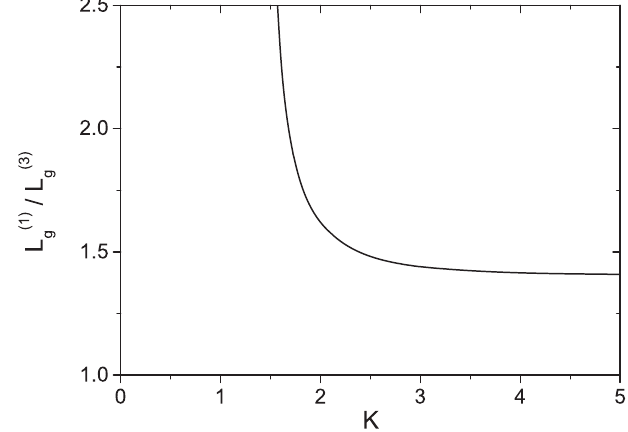
FIG. 2. Ratio of the gain length of the retuned fundamental to the gain length of the third harmonic (3) for lasing at the same wavelength versus rms undulator parameter K . The ratio is derived in the frame of the three-dimensional theory for an optimized beta-function and negligible energy spread